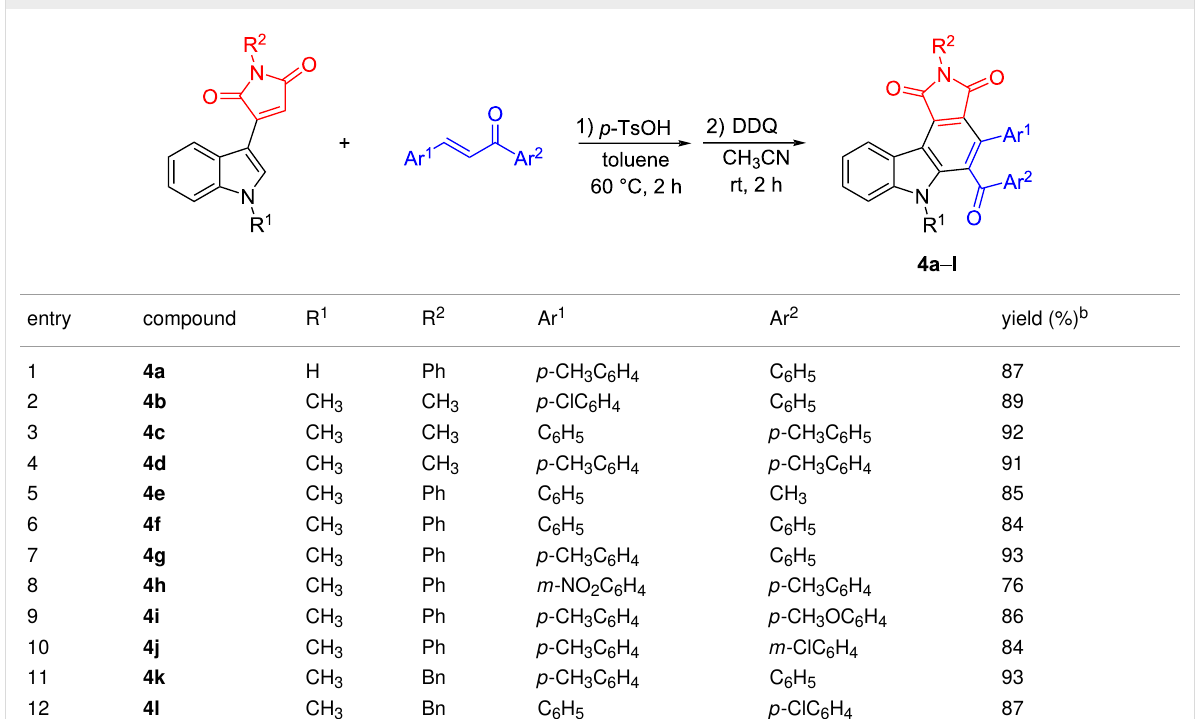
Table 1: Synthesis of pyrrolo[3,4- c ]carbazoles 4a–l . a